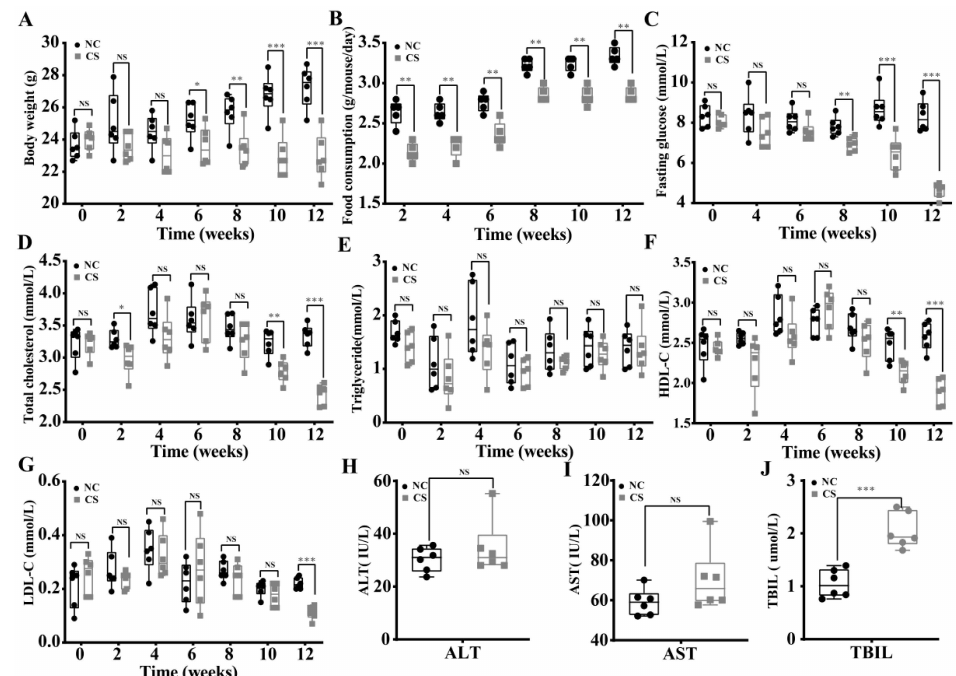
Figure 2. Effects of cigarette smoke exposure on the physiological and biochemical indicators of mice. ( A ) Body weight. ( B ) Food consumption. ( C ) Fasting glucose. ( D ) Serum total cholesterol. ( E ) Serum triglyceride. ( F ) Serum HDL-C. ( G ) Serum LDL-C. ( H – J ) AST ( H ) and ALT ( I ) activities and TBIL ( J ) contents in blood serum. LDL-C, low-density lipoprotein cholesterol; HDL-C, high-density lipoprotein cholesterol; AST, aspartate aminotransferase; ALT, alanine aminotransferase; TBIL, total bilirubin. NC, mice treated with normal air exposure; CS, mice treated with cigarette smoke exposure. Comparison of means between groups was performed with Student’s t -test. (*, p < 0.05; **, p < 0.01; ***, p < 0.001; NS, not significant; n =